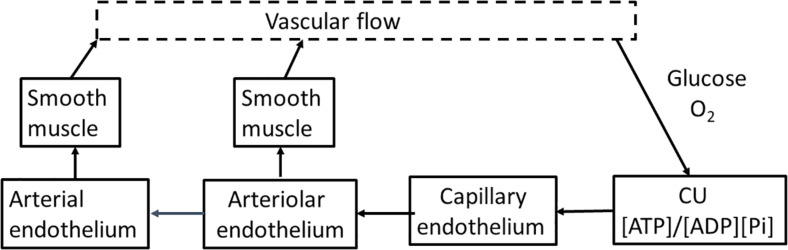
A flow diagram for regulation of cerebrovascular blood flow. Blood flow is regulated through the energy state of functional units made up of metabolically coupled neurons and astrocytes. The energy state provides the set point that is responsible for determining the need for increase or decrease in flow to maintain that set point. The functional units communicate electrically with the capillary endothelium through the astrocyte, altering the endothelial membrane potential. The change in endothelial membrane potential propagates very rapidly (>1 mm/s) along the capillary to the penetrating arteriole and then further into the source arteries. The endothelial cells are coupled with smooth muscle cells that cover the endothelium of the arterial system. As the signal passes along arterial vessels, changes in endothelial membrane potential alter Ca2+ levels in the smooth muscle cells. Contraction and relaxation of the smooth muscle controls arteriolar and arterial diameter and thereby blood flow to the tissue.